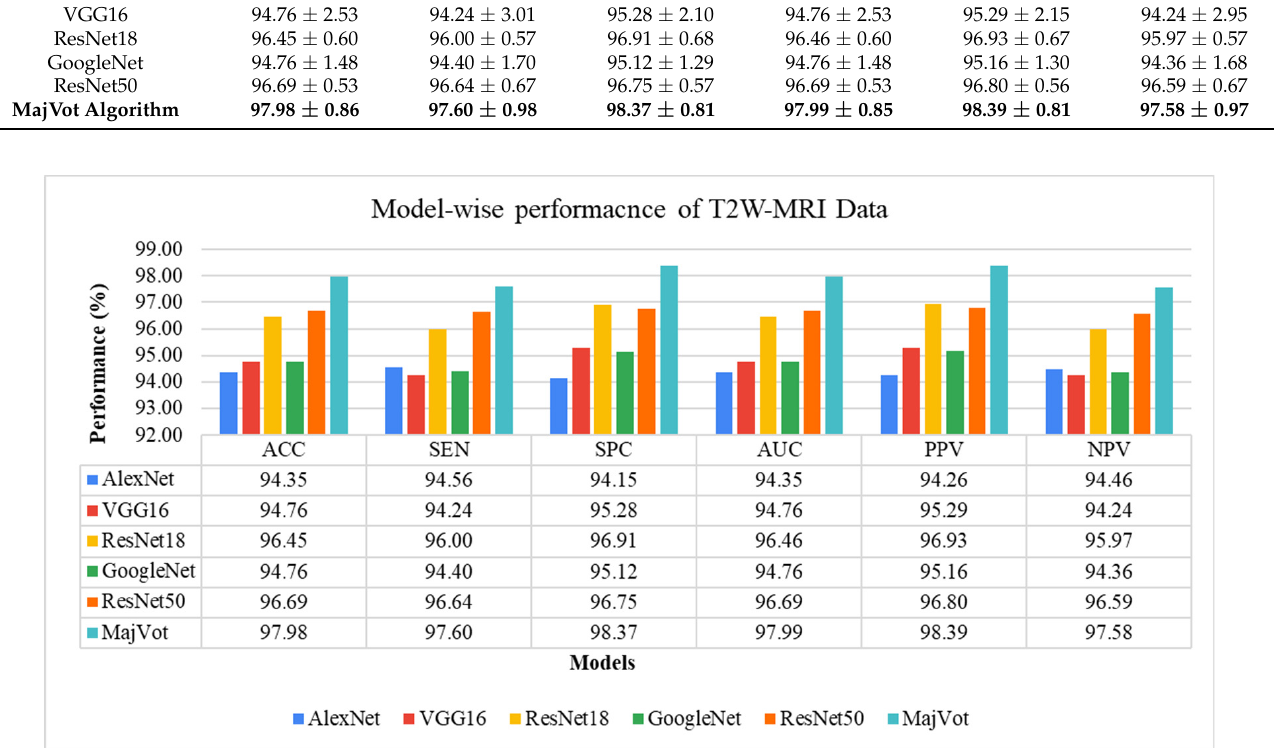
Figure 9. Five-fold test performance of T2W-MRI Data.